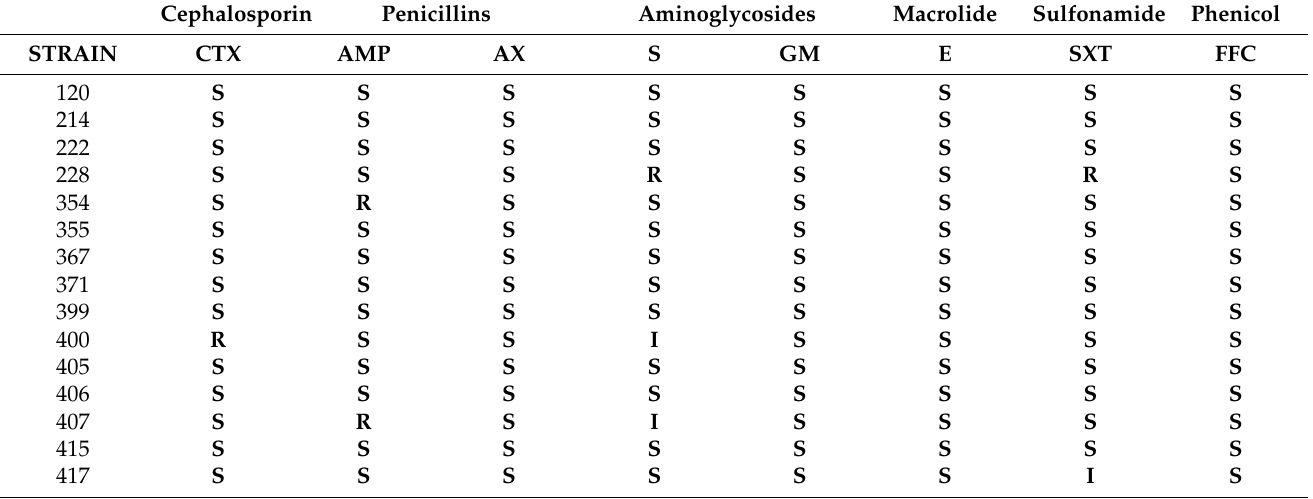
Table 3. List of the strains and the antibiotics used for the antibiograms (CTX: cefotaxime, AMP: ampicillin, AX: amoxicillin, S: streptomycin, GM: gentamicin, S: streptomycin, E: